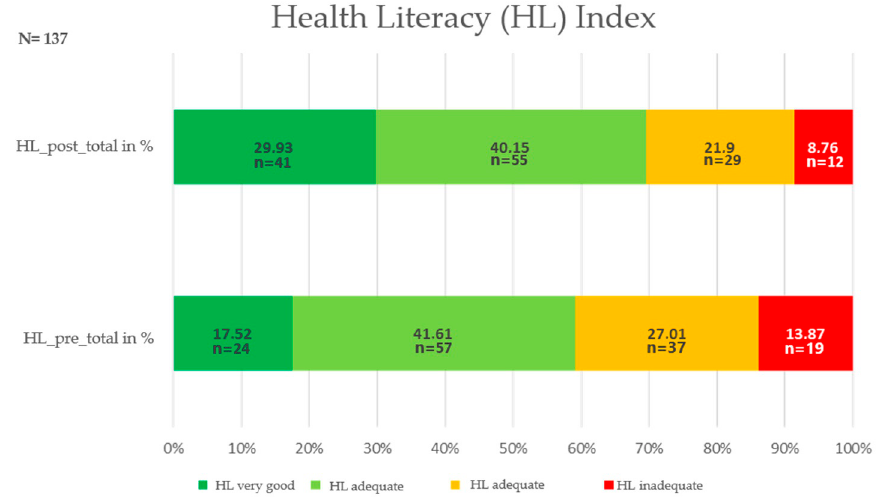
Figure 1. Health literacy index.